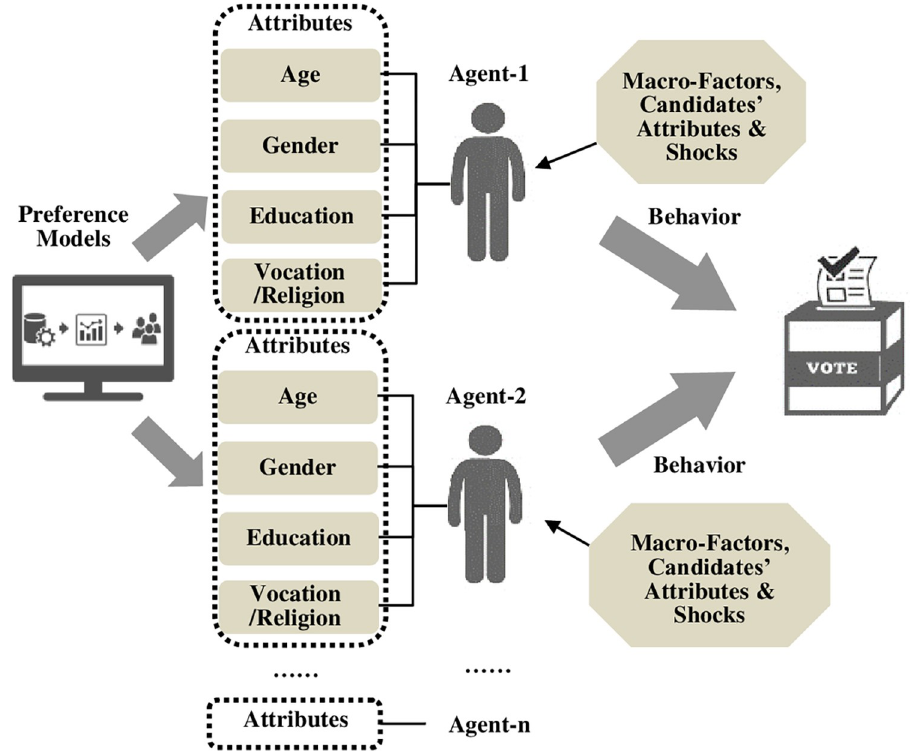
Fig 2. A Schematic illustration of simulating How agents vote with